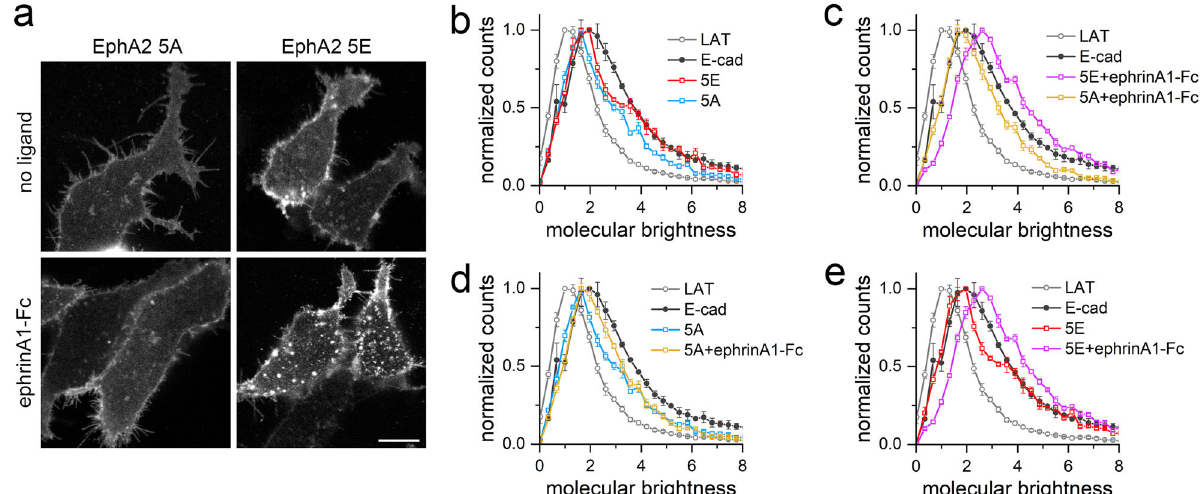
Fig. 6 FIF analysis of oligomerization for EphA2 kinase-SAM linker mutants. a Representative images of HEK293T cells transiently transfected with EphA2 5A-EYFP or EphA2 5E-EYFP and stimulated with ephrinA1-Fc or unstimulated (no ligand). More fl uorescent patches appear to be present in the cells expressing the EphA2 5E mutant and stimulated with ephrinA1-Fc compared to the other conditions. Scale bar = 10 μ m. b Normalized FIF brightness distributions for the EphA2 5A ( n = 134) and 5E ( n = 129) mutants in the absence of ligand treatment. Data are compared to previously published monomer (LAT) and dimer (E-cad, E-cadherin) controls 47 . The brightness distribution curves for EphA2 5A and 5E are between the two controls, suggesting that both mutants exist in a monomer-dimer equilibrium. c Normalized FIF distributions for the EphA2 5A ( n = 122) and 5E ( n = 128) mutants stimulated with a saturating concentration of ephrinA1-Fc. The brightness distribution curve for the EphA2 5A mutant is between the two control curves, whereas the EphA2 5E mutant distribution curve is shifted to larger brightness values than the E-cadherin curve, suggesting the formation of higher-order oligomers. d , e Comparison of the normalized FIF distributions for d the EphA2 5A mutant and e the EphA2 5E mutant with and without ephrinA1-Fc. EphrinA1-Fc causes only a small shift in the curves for the EphA2 5A mutant but a large shift in the curve for the EphA2 5E mutant, suggesting that the EphA2 5E mutant can much more readily form higher order oligomers. The counts of molecular brightness were normalized, averaged, and plotted along with their standard errors in b – e . Source data for b , c , d , e are provided in the Source Data fi